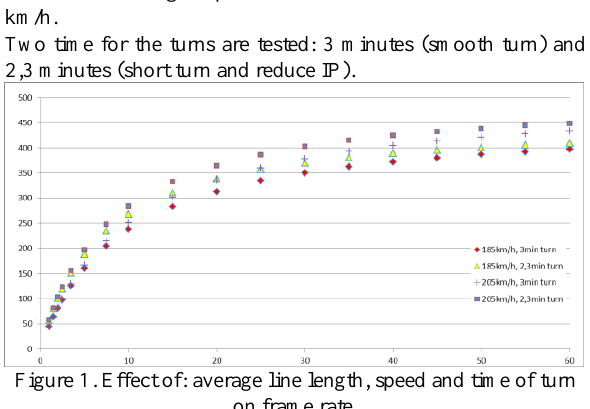
Figure 1. Effect of: average line length, speed and time of turn on frame rate.